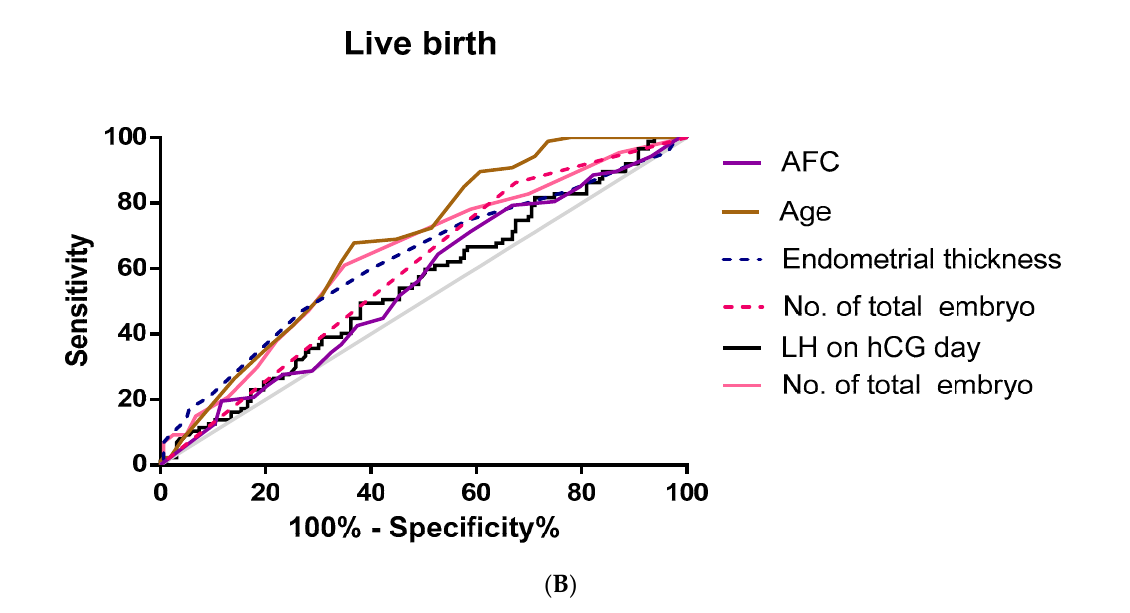
Figure 1. Receiver operating characteristic (ROC) curve for age, AFC, LH on hCG day, endometrial thickness, no. of embryos transferred, and no. Of total embryos for prediction of clinical pregnancy and live birth. ( A ) Clinical pregnancy; ( B ) live birth. As shown in Table 3, multivariate regression analysis used to predict clinical pregnancy showed that serum LH (AUC 0.609, p = 0.003, cut-off value = 8.46 miu/mL), age (AUC 0.707, p < 0.01. cut-off value = 3 7.5), AFC (AUC 0.619, p < 0.01, cut-off value = 10.5), endometrial thickness (AUC 0.583, p = 0.02, cut-off value = 7.75 mm), the total embryo number (AUC 0.67, p < 0.01, cut-off value = 4.5), and the average number of embryos transferred (AUC = 0.614, p = 0.02, cut-off value = 1.5) had accuracy by the area under the curve. Table 3. ROC analysis of the area under the curve and the specific cut-off value for predicting clinical pregnancy.